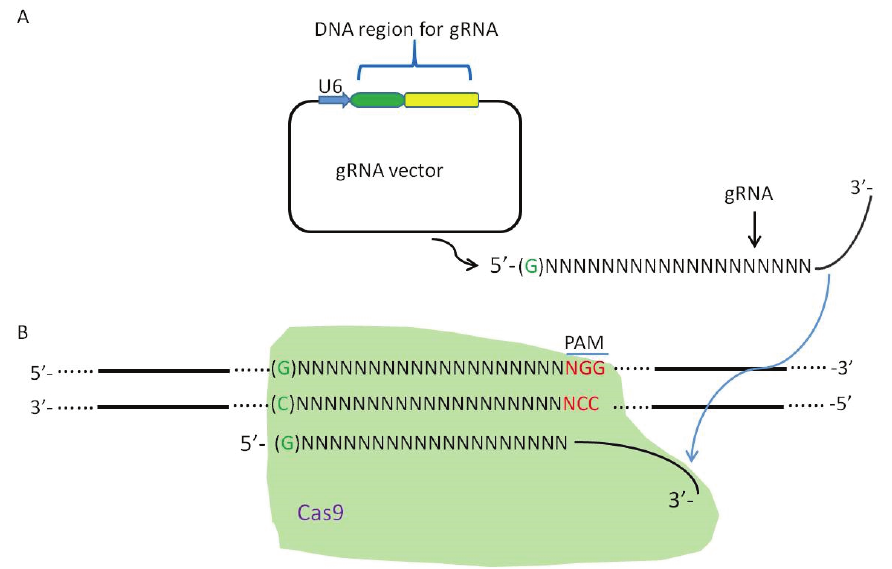
in the cytoplasm. mRNA as the mRNA is transcribed